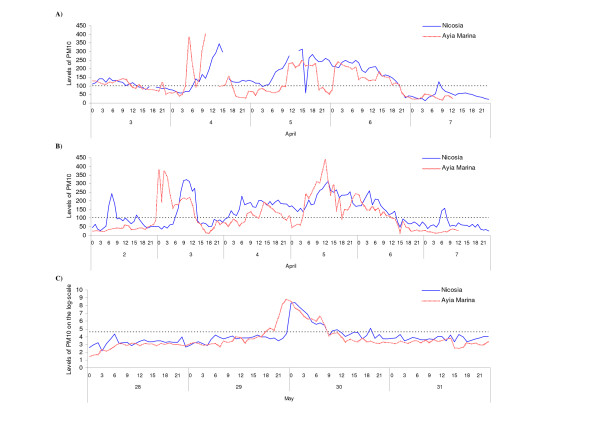
Typical levels of PM10 concentrations during a dust storm. Hourly levels of PM10 concentrations as recorded at Nicosia Central and Ayia Marina stations during A) a suspected dust storm, not confirmed by Meteorological Services records, between 4–6 April 2000, B) a dust storm confirmed by Meteorological Services records between 3–6 April 2003 and C) a confirmed dust storm with the highest recorded levels of PM10 (log-scale) between 29–30 May 2003.